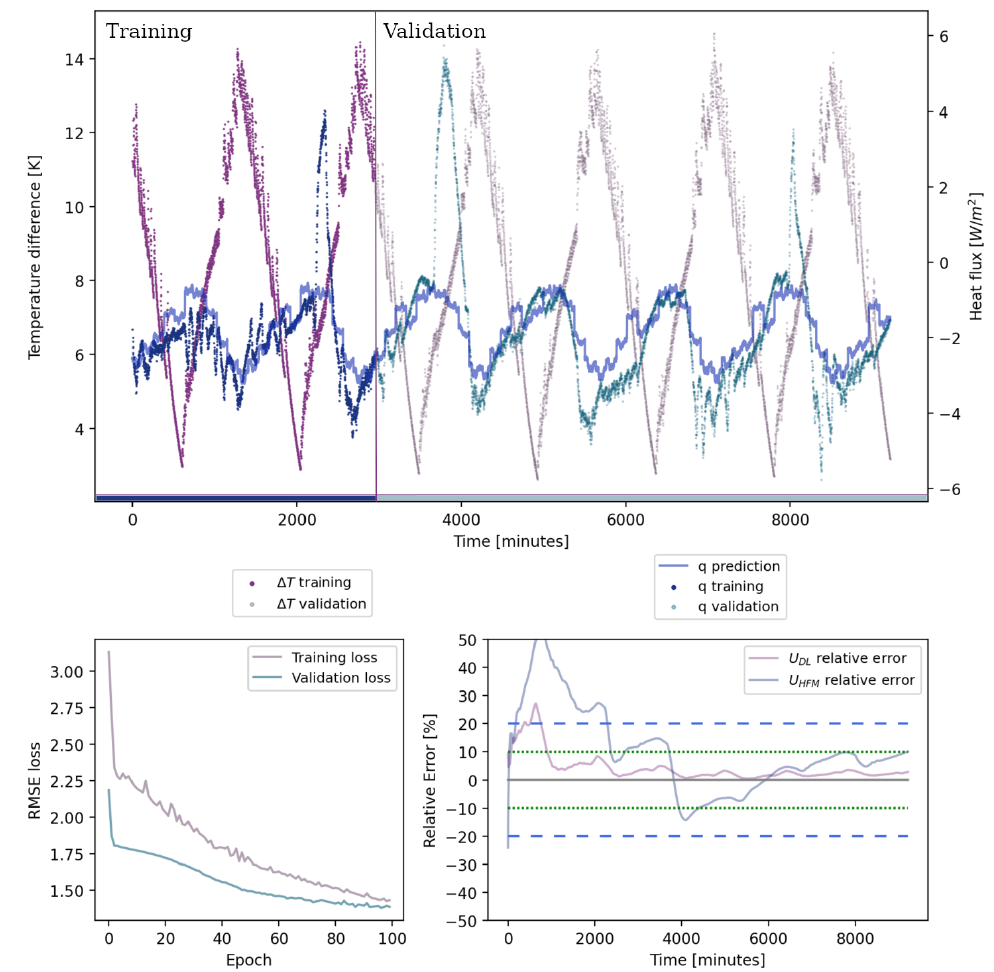
Figure 8. Results for the deep-learning model developed for S2 under winter conditions.